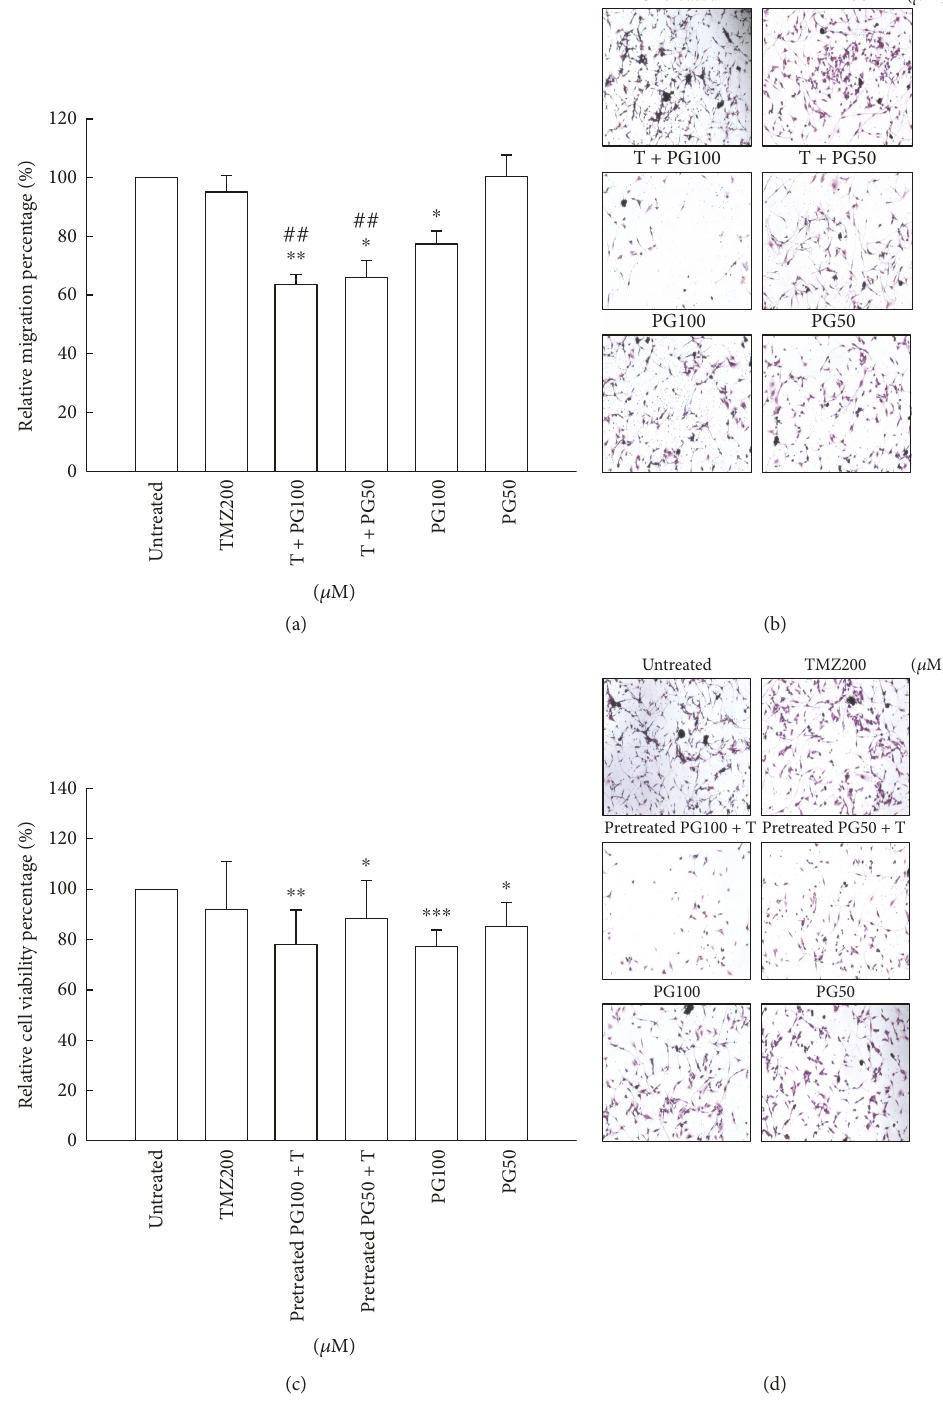
Figure 2: Evaluation of migration with TMZ, PG, or TMZ/PG treatment. (a, b) U87MG cells (1 × 10 4 ) were plated in 24-well Millicell hanging cell culture inserts with an 8 μ m pore size membrane for 24h and then treated with TMZ (200 μ M), PG (50 or 100 μ M), and their combination for 48h. (c, d) U87MG cells (1 × 10 4 ) were plated in 24-well Millicell hanging cell culture inserts with an 8 μ m pore size membrane for 24h and then treated with TMZ (200 μ M) or PG (50 or 100 μ M) for 48 h or pretreated with PG (50 or 100 μ M) for 6 h and then treated with (200 μ M) for 48h. (a, c) Transwell migration assay was carried out. The migrated cells were stained with crystal violet. The dye was eluted with 33% acetic acid, and crystal violet absorbance was measured at 570 nm using a microplate reader. The values are presented as mean ± standard deviation ( n = 5 – 8) of individual experiments. Signi fi cant di ff erences for the untreated group and TMZ group were ∗ P < 0 05 , ∗∗ P < 0 01 , ∗∗∗ P < 0 001 , and ## P < 0 01 . (b, d) Random fi elds from each of the triplicate migration assays were counted using phase contrast microscopy (magni fi cation